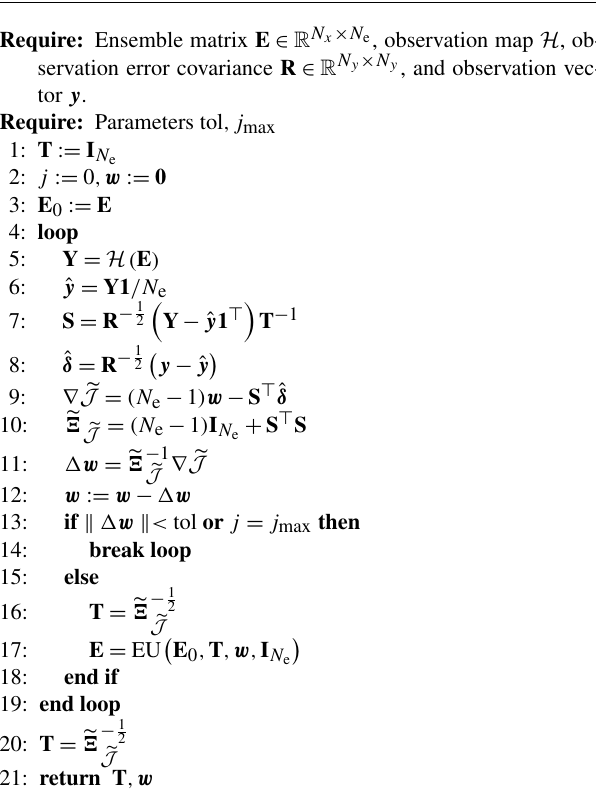
Algorithm A9 Maximum likelihood ensemble transform (MLET).